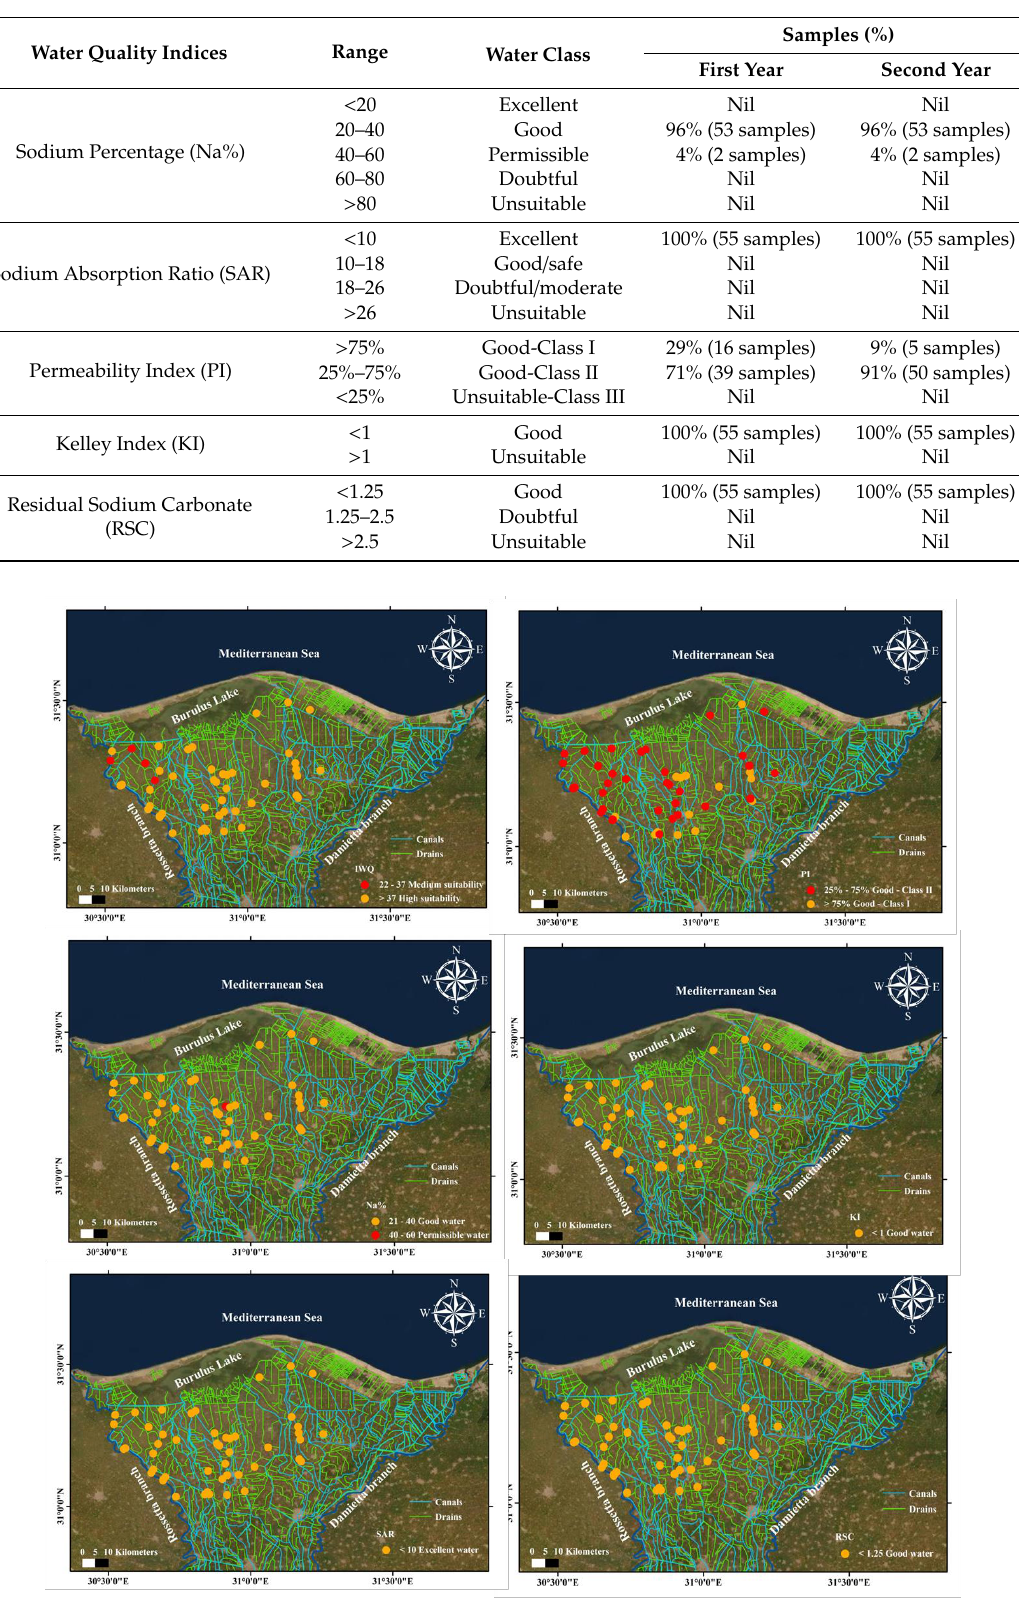
Figure 5. Spatial variation maps of Irrigation Water Quality Indices in year 2018.